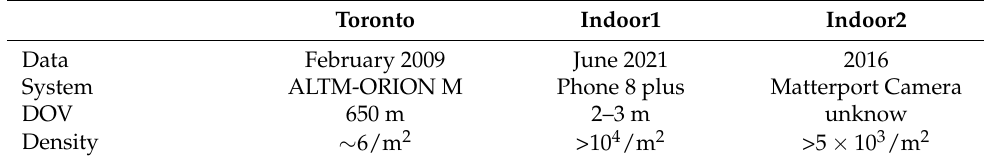
Table 2. The properties of the datasets.